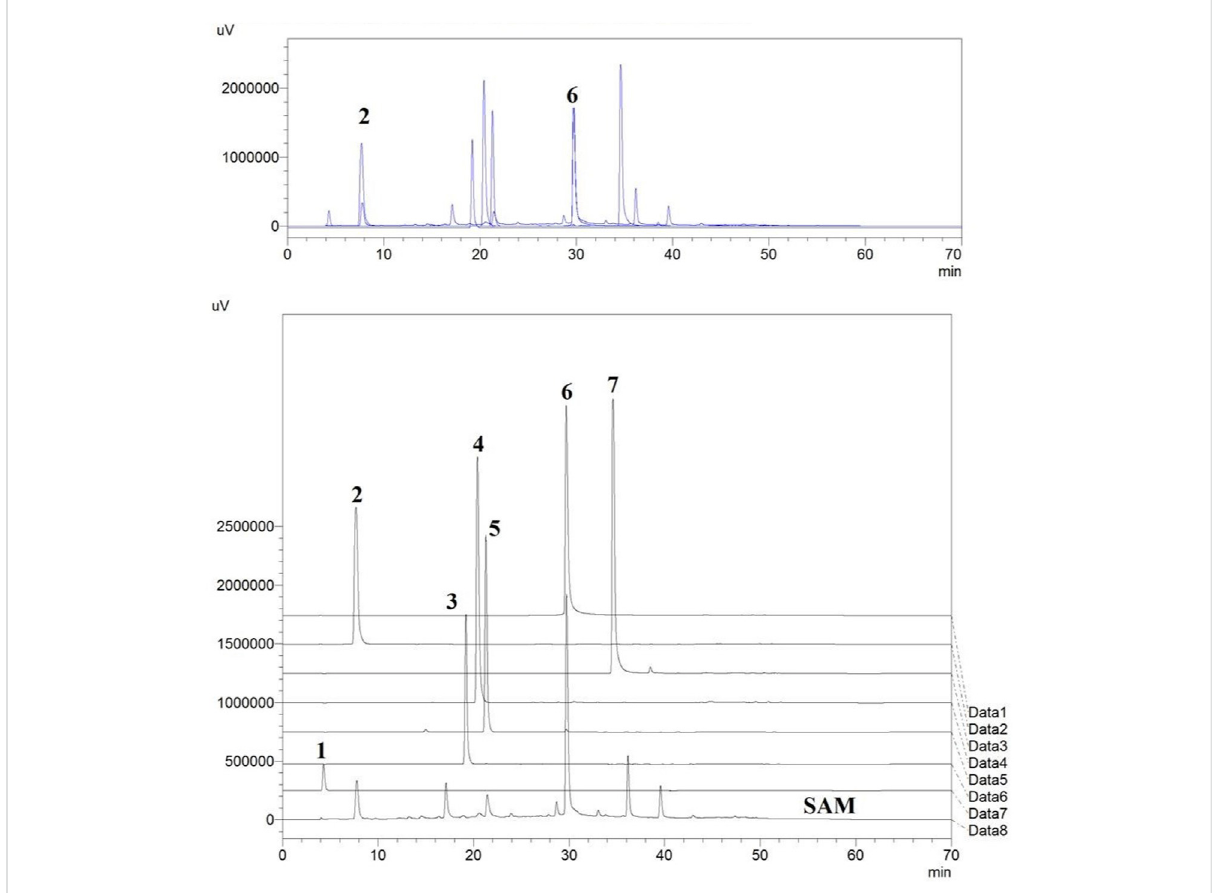
FIGURE 1 Standardsvis.(1)Ascorbicacid,(2)Gallicacid,(3)Vanillicacid,(4)Caffeicacid,(5)Syringicacid,(6)Ellagicacid,(7)Quercetinoverlappedwiththe HPLC chromatogram of extract of fruits of S. apetala